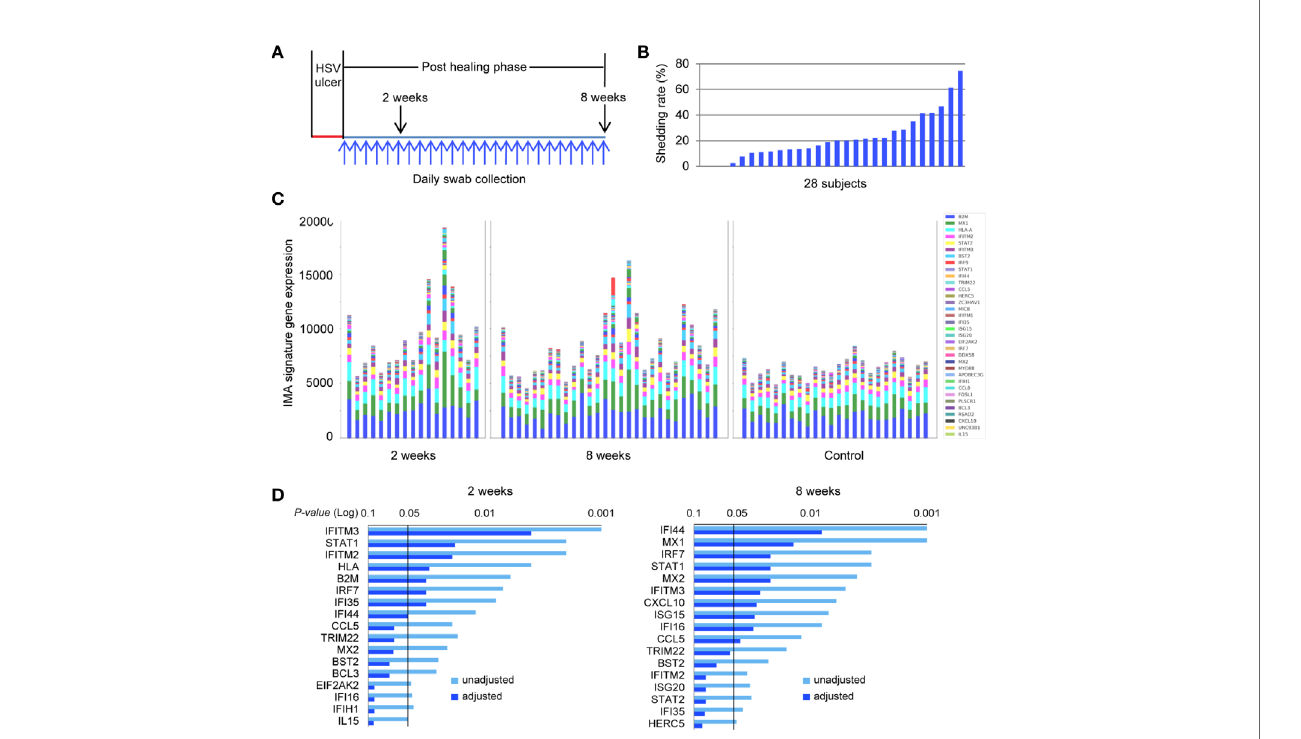
FIGURE 6 | IMA signature expression pattern is distinct between HSV-2-affected and normal skin in a patient cohort across a wide spectrum of genital herpes outcomes. (A) Study design. Genitalia HSV-2 reactivation was monitored by daily swab collection and PCR detection for an 8-week study period after a clinical symptomatic recurrence. Skin biopsies were obtained sequentially at the original lesion site 2- and 8-week post-healing. A control biopsy was taken at the contralateral normal site at the 8-week timepoint. Daily swabs were collected starting at day 7 after the onset of a lesion-forming HSV-2 reactivation. (B) HSV-2 shedding rates were calculated as days of positive HSV DNA detection within the total numbers of days of that swabs were collected during the study period for each participant, n = 28 subjects. (C) Skin biopsies were processed for RNA extraction and whole genome transcriptional pro fi ling. The collective levels of IMA gene signature expression in post healing skin taken at week 2 (n = 17) and week 8 (n = 28) of prior HSV-2 recurrence and in normal contralateral control skin (n = 24). (D) IMA signature genes signi fi cantly associated with sites of prior HSV infection at 2- or 8-week post healing time. Multiplicity adjusted and unadjusted paired